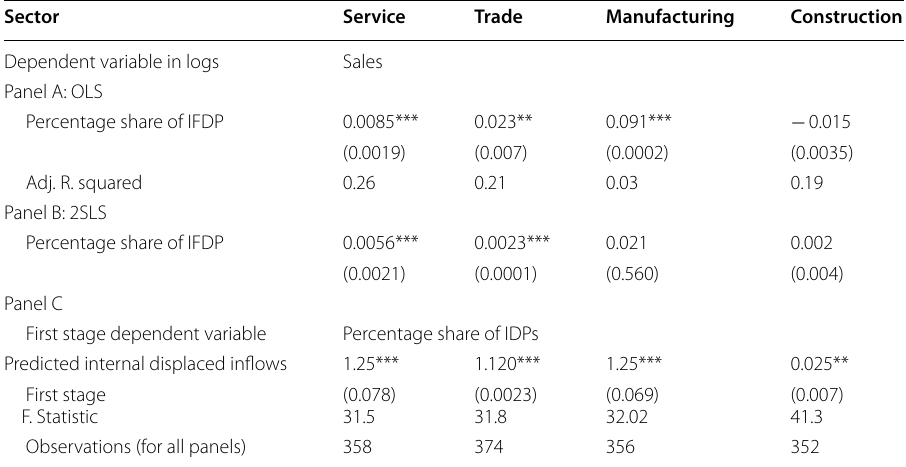
Each coefficient corresponds to a separate regression and all panels include controls for zone and year fixed effects. The standard errors clustered at the zonal level are shown in the parenthesis. *** Represents the significant level at 1%, ** represents significant at 5% and * represents significance at